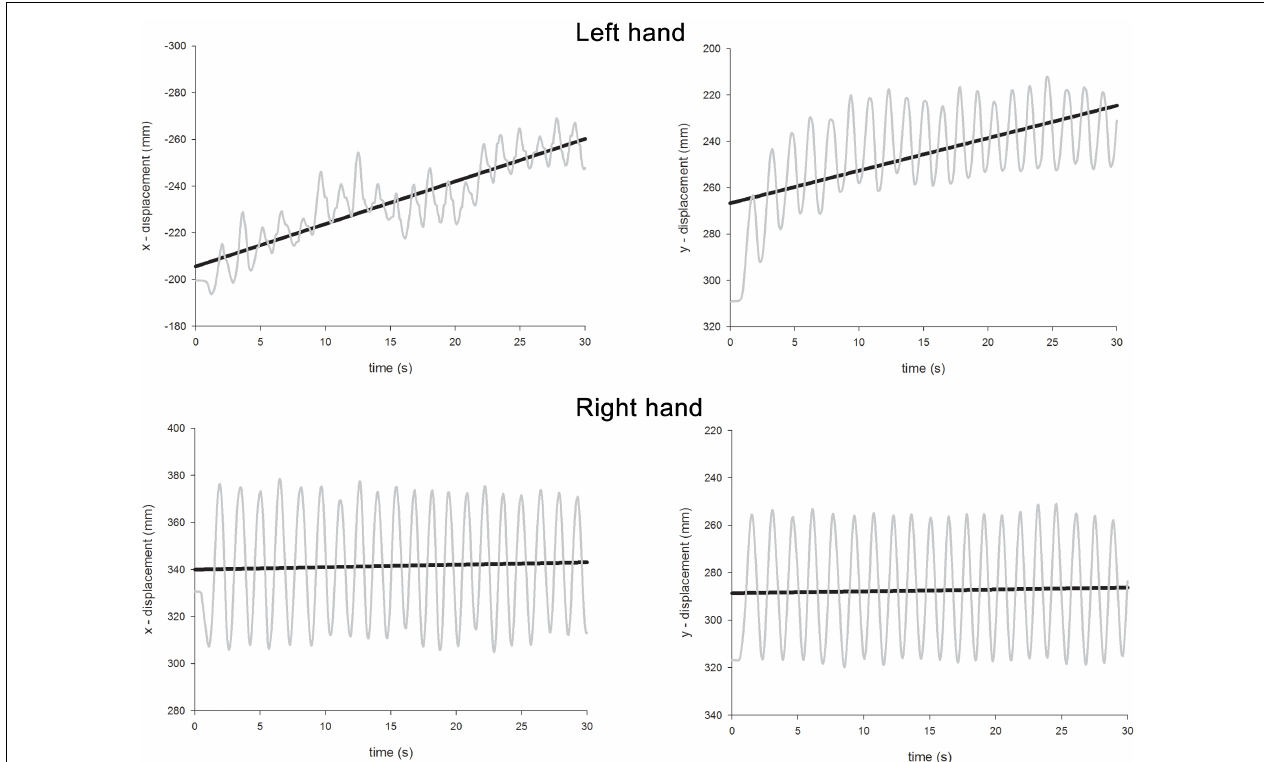
FIGURE 8 | Representative linear regression slopes for the x - and y -axes in the bimanual movement conditions when gaze was directed rightwards in Experiment 2